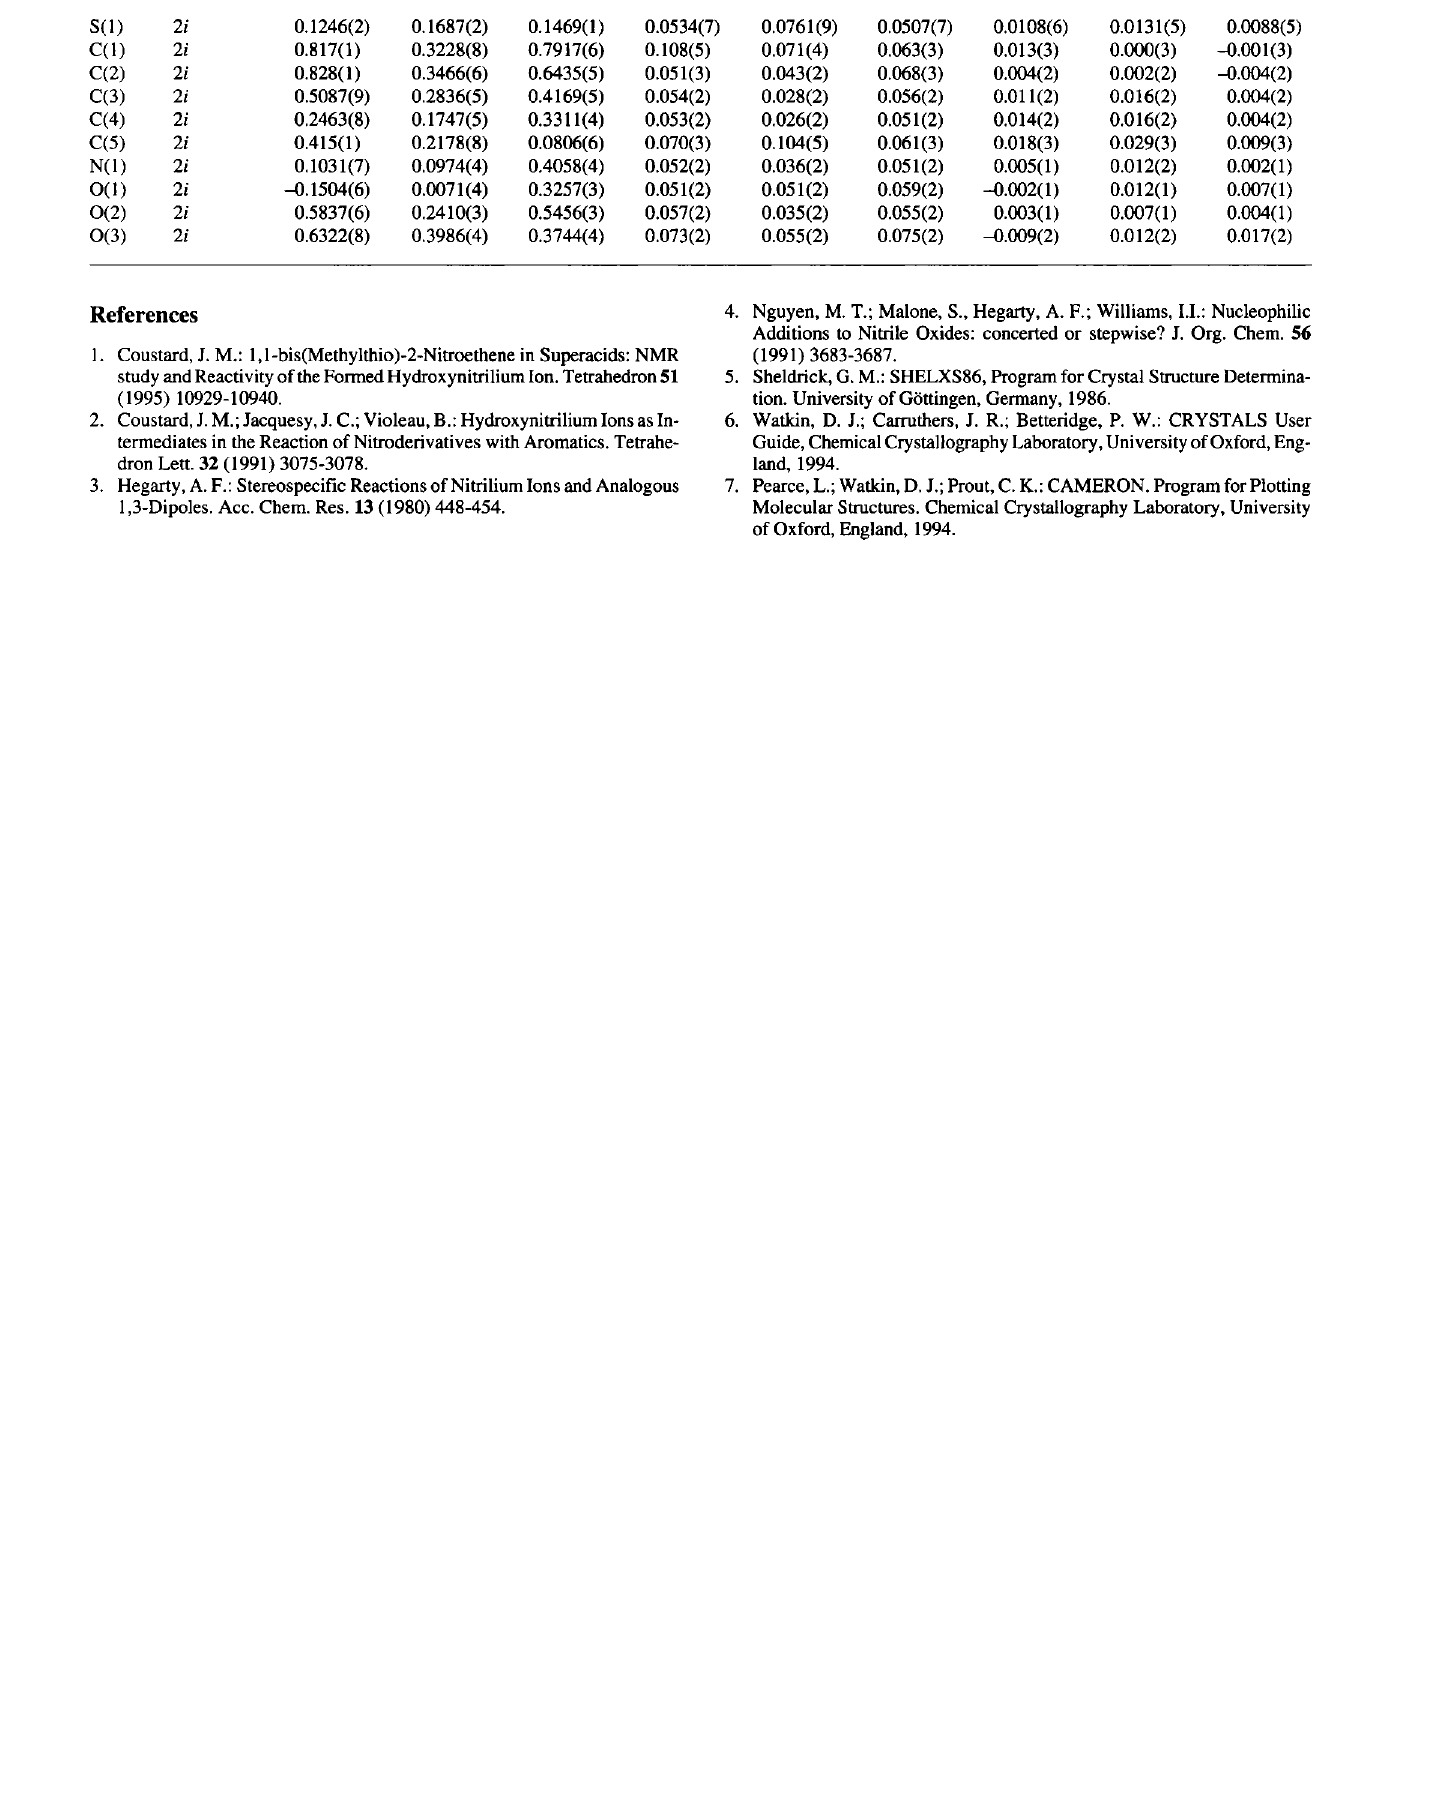
Table 3. Atomic coordinates and displacement parameters (in Ä 2 ).